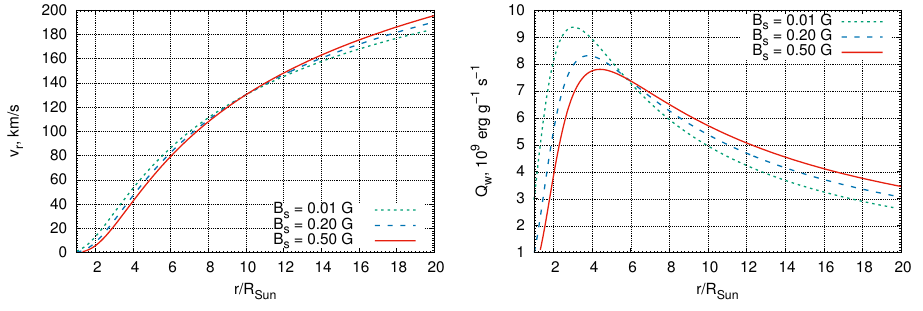
Figure 5. Distributions of the radial wind velocity v r ( left ) and the heating function Q w (88) ( right ) for the magnetic field values at the stellar surface B s used in